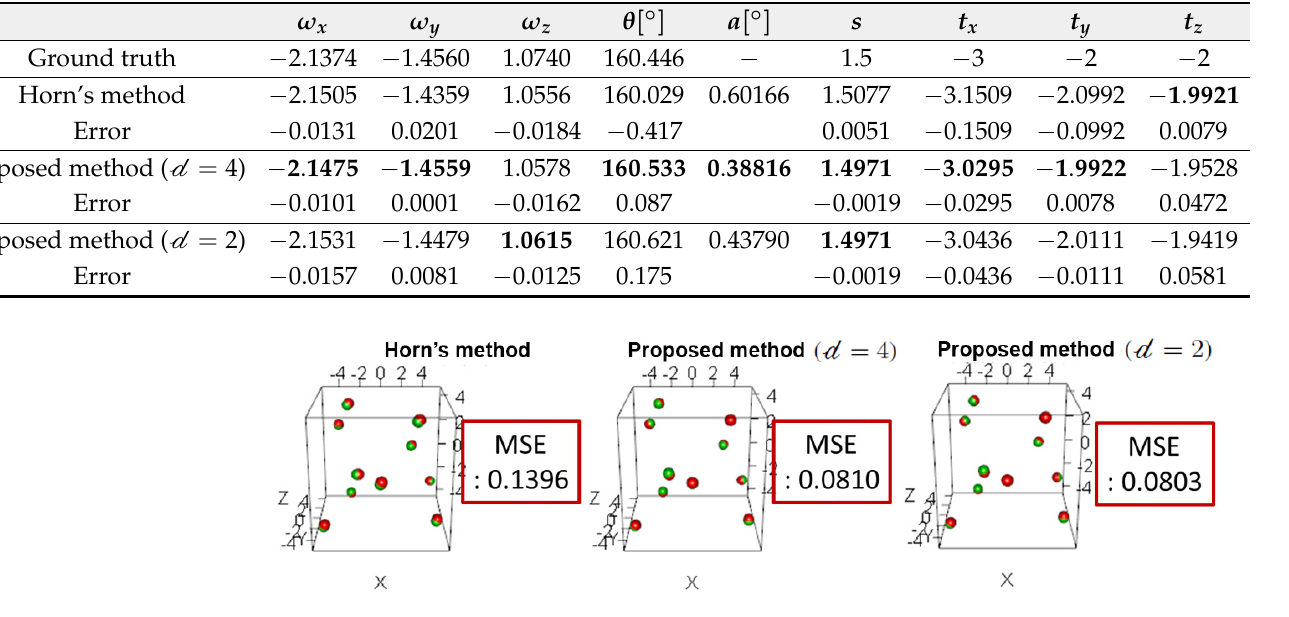
Figure 9. Comparison of relative pose estimation methods using a set of ideal